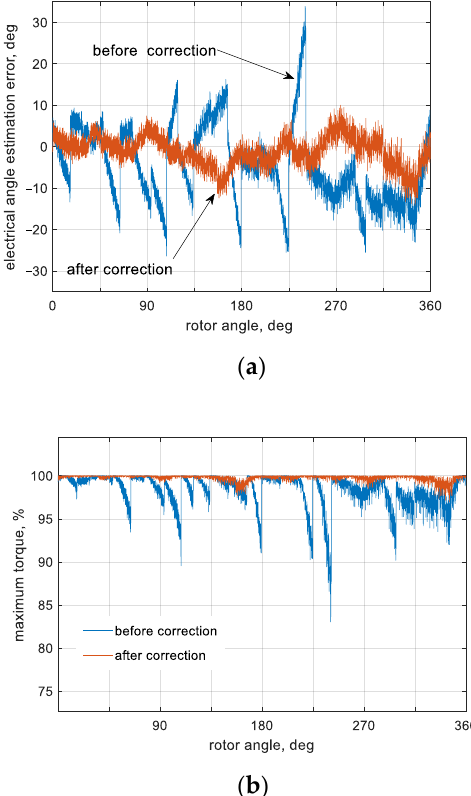
Figure 9. The course of the error in electric angle estimation as a function of the rotor position of the tested BLDC motor ( a ), and the course of the maximum possible motor torque ( b ). Standard estimation method—blue; proposed method—red.